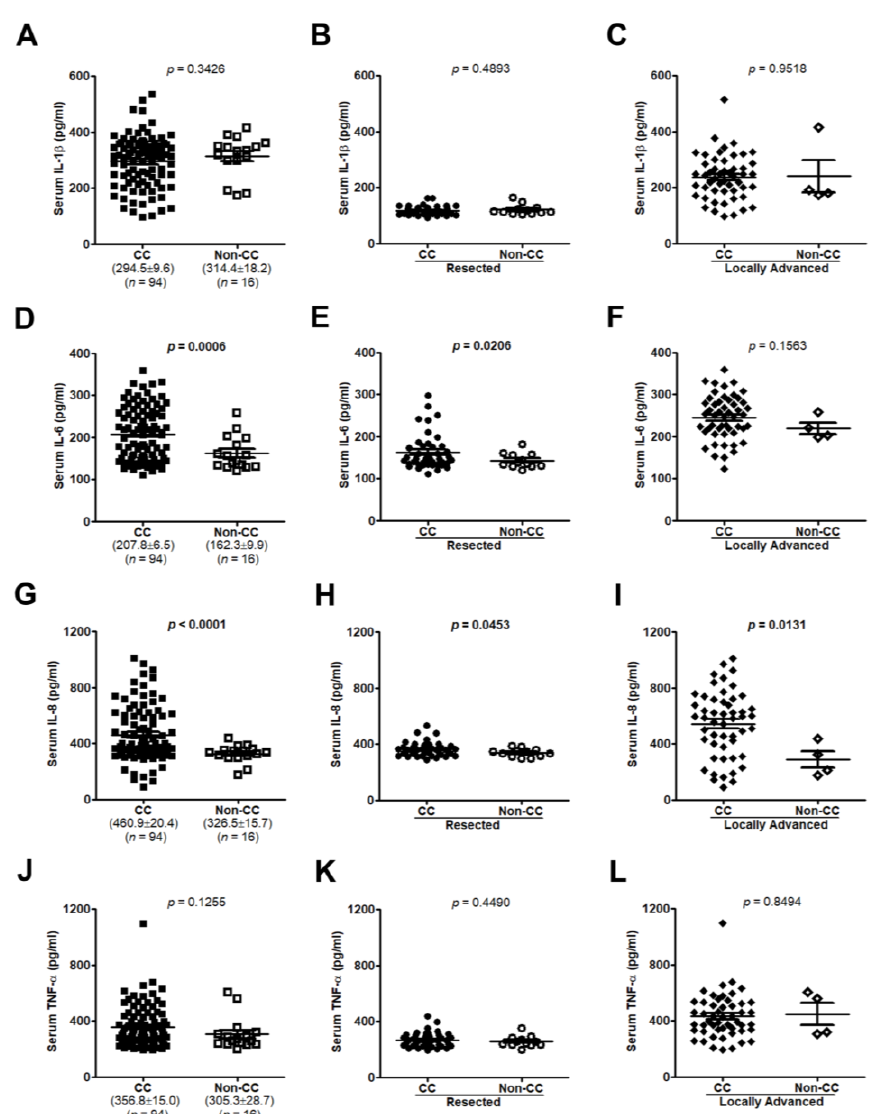
Figure 4. Serum IL-1β, IL-6, IL-8, and TNF-α levels in PC patients with or without CC. IL-1β, IL-6, IL-8, and TNF-α concentrations in patients with or without CC from all samples ( A , D , G , J ), the resected group ( B , E , H , K ), or the locally advanced group ( C , F , I , L ) were measured by enzyme-linked immunosorbent assay (ELISA). Values represent mean ± standard error of mean; two-tailed Student’s t -test. CC, patients with cancer cachexia; Non-CC, patients without cancer cachexia.